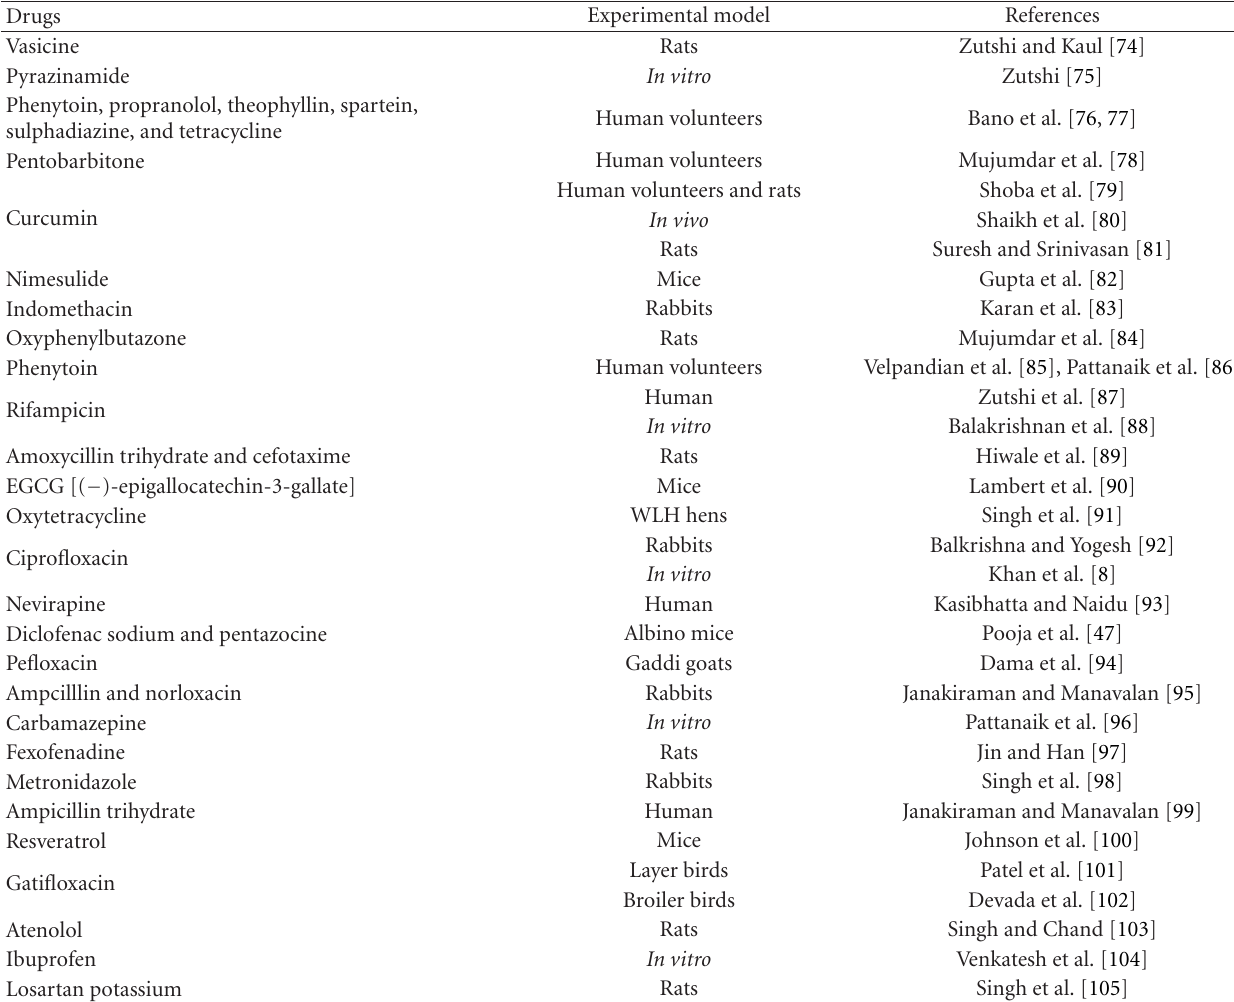
Table 3: Drugs bioenhanced by